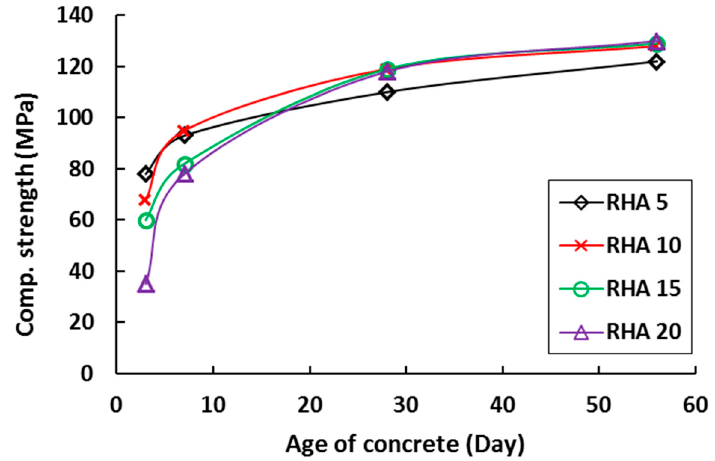
Figure 10. Influence of rice husk ash (RHA) on the compressive strength development of concrete [51].